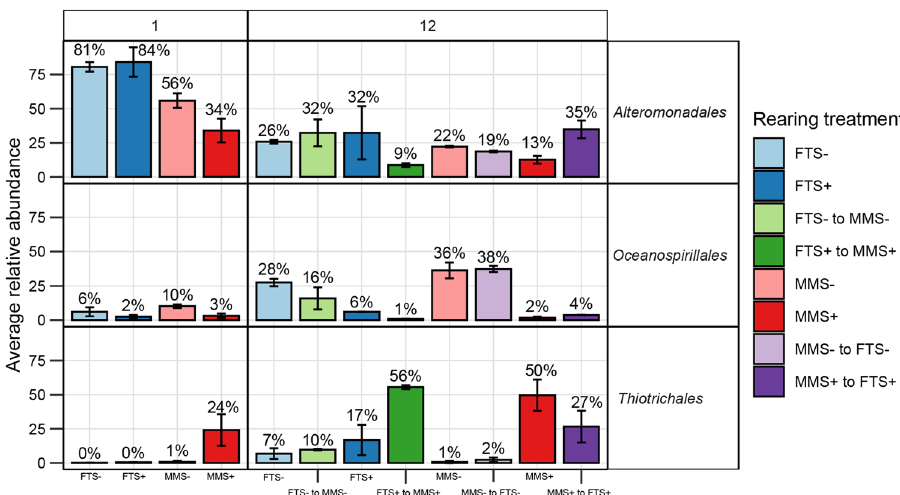
Figure 4. The relative abundance of the three most dominating orders in the dataset. These orders had a > 20% abundance in a minimum of two samples. Colours indicate the rearing treatment. The average relative abundance is shown on each sampling day, and whiskers represent the standard